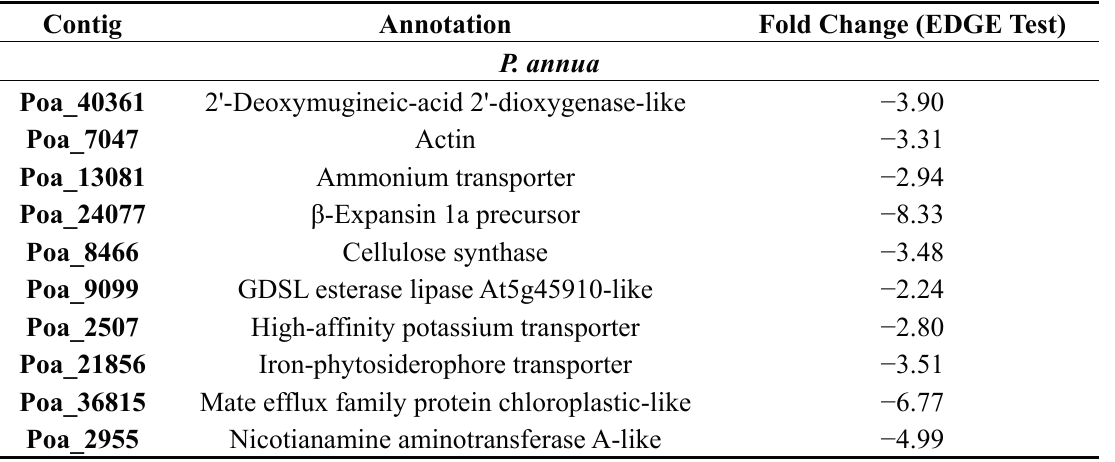
Table 2. Genes that were down-regulated under NaHCO 3 treatment (fold change < − 2, FDR-corrected p -value <